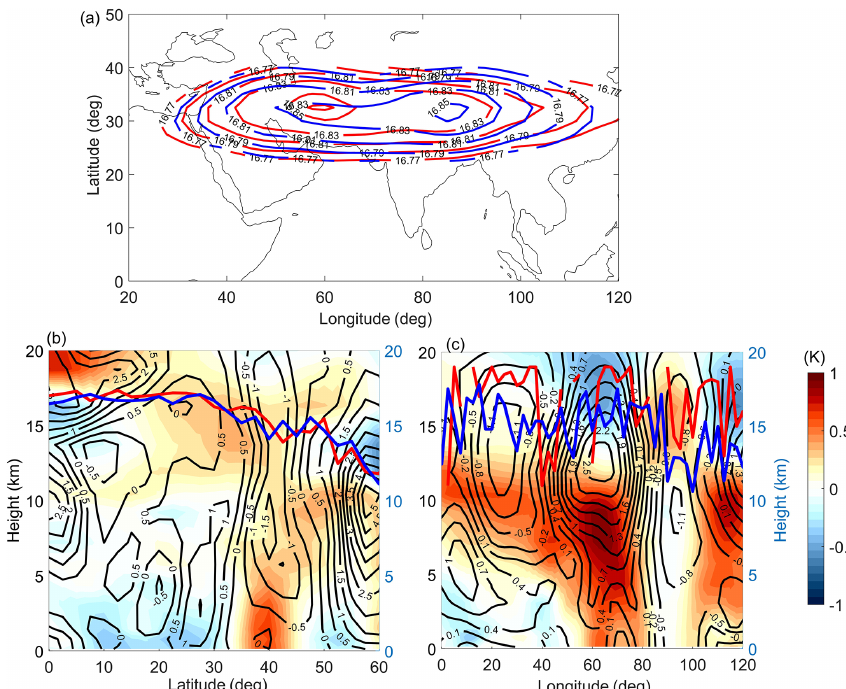
Figure 7. (a) The ASMA variability obtained from GPH at 100hPa during strong and weak monsoon years calculated based on high- resolution rainfall data in the band from 5 to 30 ◦ N and from 70 ◦ N to 95 ◦ E. The red line indicates strong monsoon years, and the blue line indicates weak monsoon years. (b) Latitude–altitude cross section of temperature (colored shading, K) and zonal wind anomalies (contour lines, ms − 1 ) estimated from the difference between strong and weak monsoon years in the longitude band from 80 to 90 ◦ E. (c) Longitude– altitude cross section of temperature and wind anomalies averaged between 30 and 40 ◦ N. The red and blue lines in panels (b) and (c) denote the tropopause altitude during respective strong and weak monsoon years estimated using GNSS RO